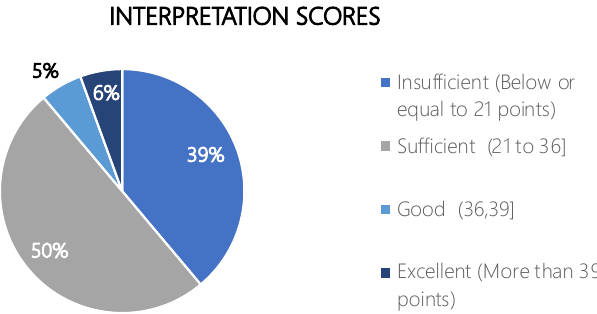
Figure 22. Interpretation Experiment